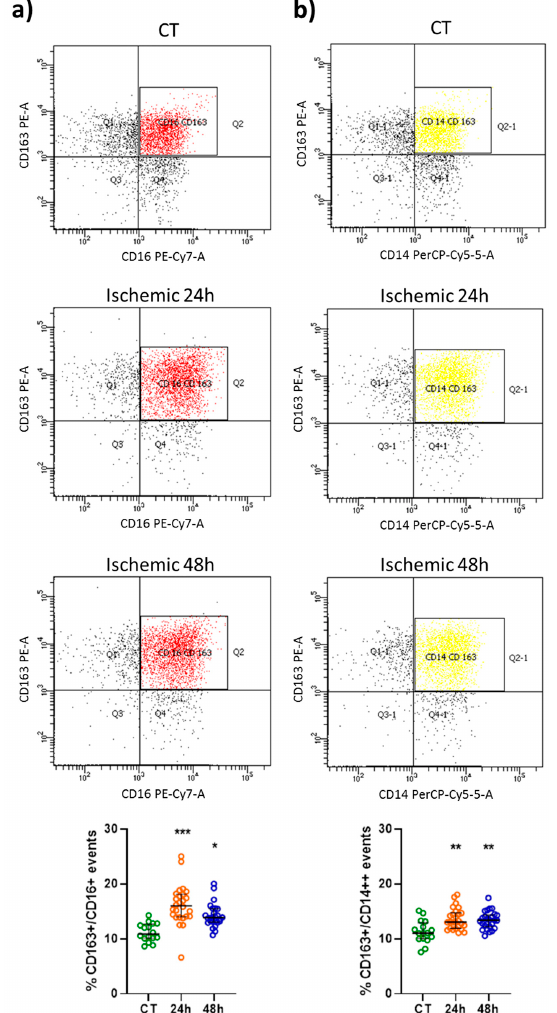
Figure 1. Representative flow cytometry density plots and scatter plots showing the percentage of CD163+/CD16+ (red) ( a ) and CD163+/CD14++ (yellow) ( b ) events in healthy subjects (CT; n = 16) and in patients 24 and 48 h after an ischemic stroke ( n = 26). Data are shown as the median and interquartile range. A Kruskal–Wallis test, followed by Dunn’s post-hoc test: * p < 0.05, ** p < 0.01, and *** p < 0.001 vs. CT.